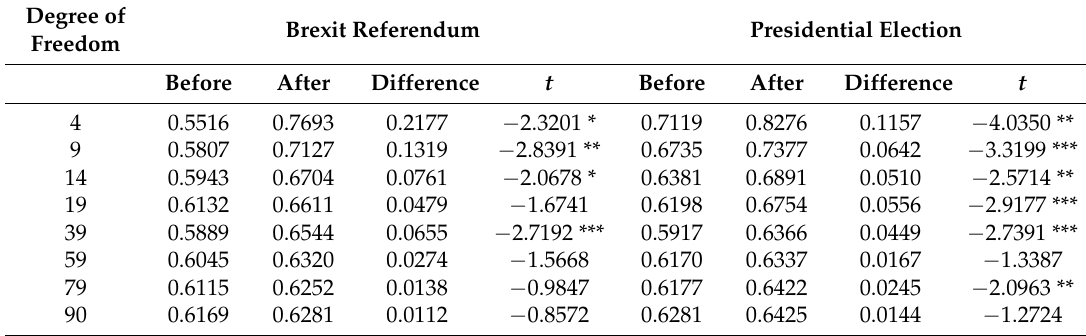
Table 4. Difference in means of DCC coefficients before and after each